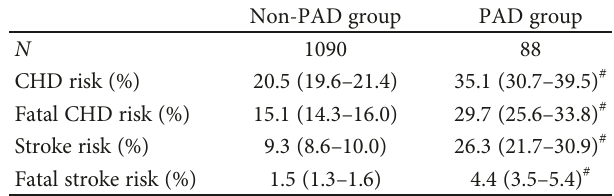
Table 1: General characteristics of subjects. Table 2: Comparison of CHD and stroke